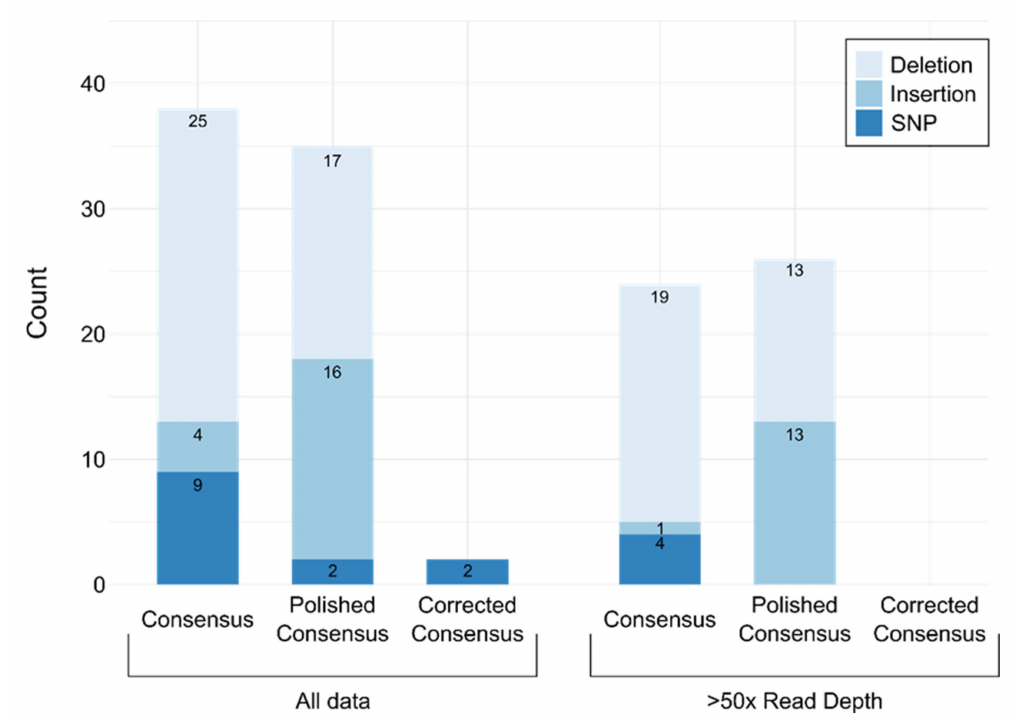
Figure 1. Errors observed in consensus sequences generated from MinION sequencing data by three methods. Number of di ff erences in the nucleoprotein gene (1353 nt) for raw consensus (Raw Consensus), consensus after polishing with raw reads using Nanopolish (Polished Consensus), and after manual correction of indels in homopolymer regions (Manual Correction) compared to consensus generated by Sanger sequencing is shown. Insertions, deletions, and single nucleotide changes (miscalled bases or SNPs) are shown in di ff erent shades of blue. Number of each type of error is depicted on the bars. Data shown include data from all sequences (left) and those sequences produced with > 50x read depth (right).